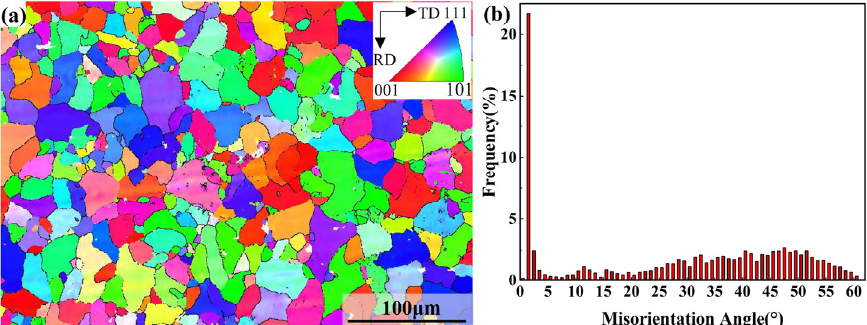
Figure 1. Initial microstructure of Al5083: ( a ) EBSD IPF map. ( b ) Misorientation angle distribution.